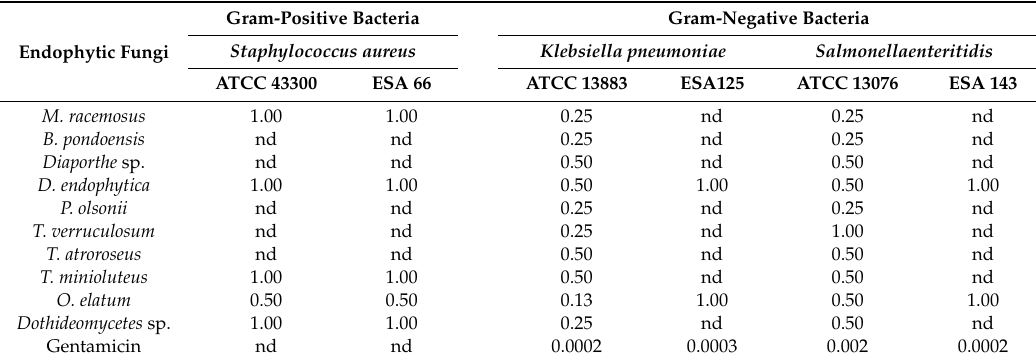
Table 6. Minimum inhibitory concentration (MIC) (mg / mL) of extracts from endophytic fungi isolated from S. terebinthifolius